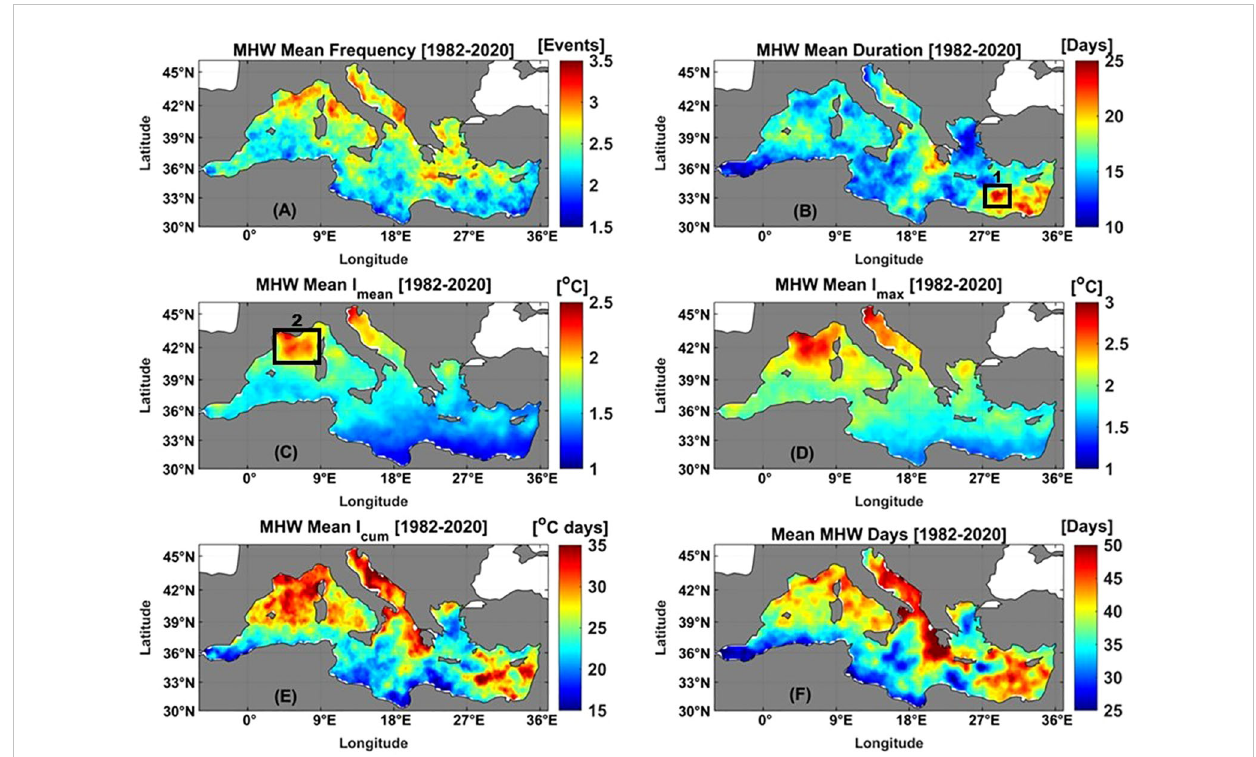
FIGURE 4 Main characteristics of marine heatwaves in the Mediterranean Sea during the study period (1982-2020), (A) mean MHW frequency (events), (B) MHW duration (days), (C) mean MHW intensity Imean (°C), (D) maximum MHW intensity Imax (°C), (E) MHW cumulative intensity Icum (°C.days), and (F) MHW total days (days). The black rectangles on panel B and C is showing the selected study regions that represents the EMB and the WMB,